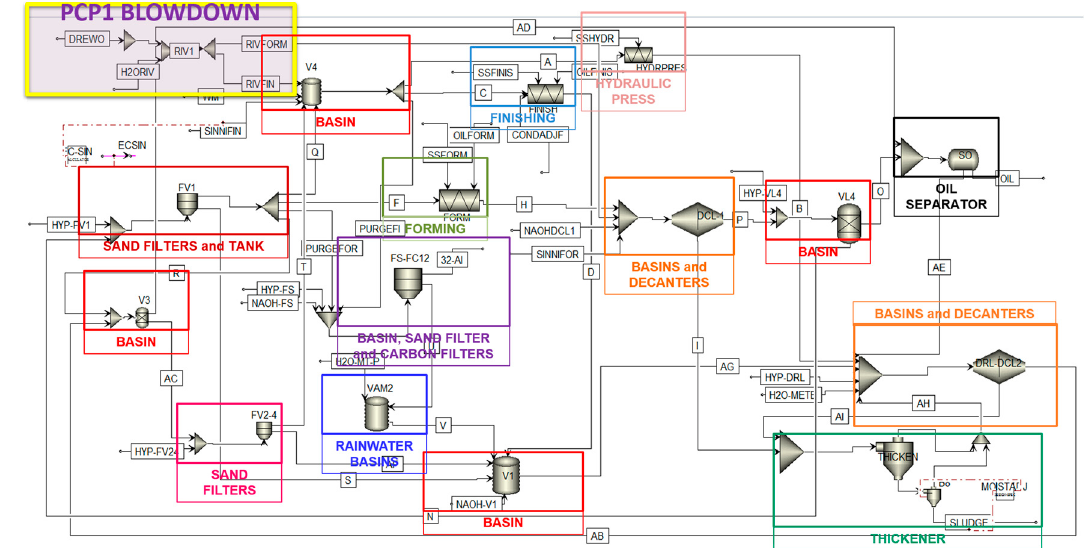
Figure 3. Aspen Plus ® based flowsheet of pipe plant washing water network.